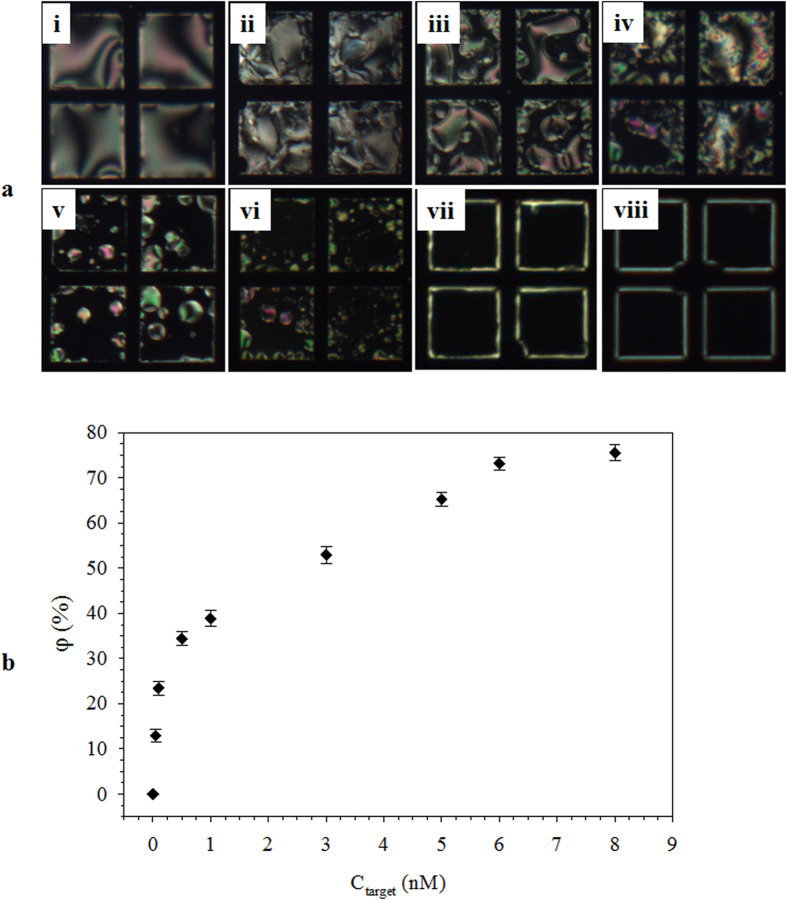
(a) Polarized optical microscopy images of TEMDTAB/DNAs at ssDNAtarget concentrations (Ctarget) of (i) 0.05, (ii) 0.1, (iii) 0.5, (iv) 1, (v) 3, (vi) 5, (vii) 6, and (viii) 8 nM. (b) The loss of brightness (φ) as a function of Ctarget. The error bars represent standard deviation. TEMDTAB/DNAs, liquid-crystal-filled transmission electron microscopy grids coated with dodecyltrimethylammonium bromide (DTAB) and ssDNAprobe.